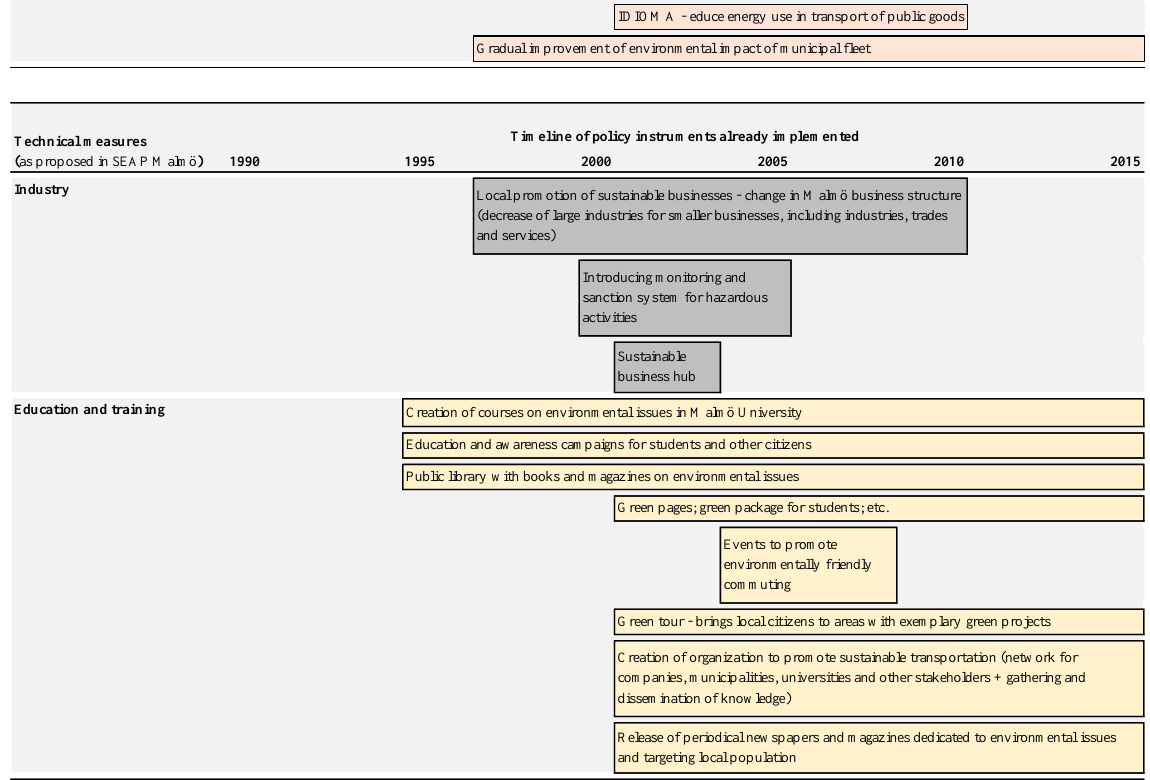
Figure A1. Timeline of policy instruments implemented by the municipality of Malmö per technical measure, between 1990 and 2015.